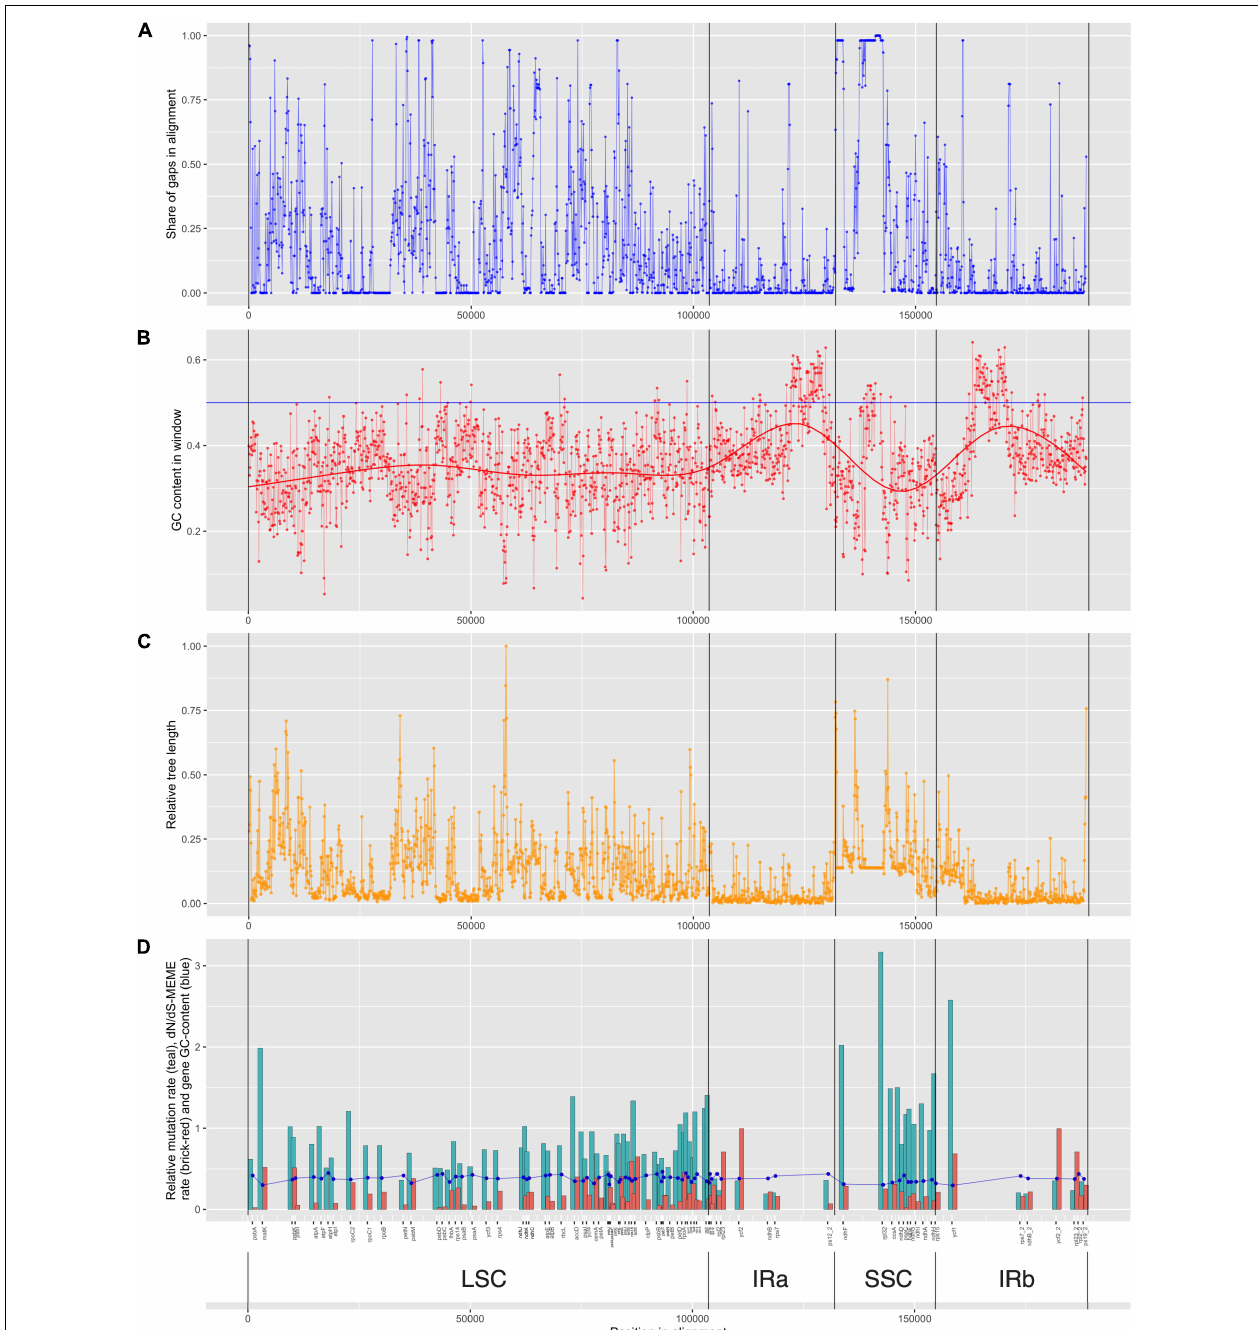
FIGURE 6 | Information on alignment and gene features. Structural components of plastome genomes and genes’ positions are shown [ LSC , large single-copied region; SSC , small single-copied region; IRa and IRb , inverted repeats (A,B) ]. (A) Share of gaps in alignment in the window of 100 bp. Dots are connected with a line for visibility. (B) GC-content in the window of 100 bp. Dots are connected with a line for visibility. A bold line shows regression estimating of GC-content. (C) Relative tree length. Dots are connected with a line for visibility. (D) Relative mutation rate (teal), Kn/Ks-MEME rate (brick-red) bar-plot and gene GC-content (blue). Dots are connected with a line for